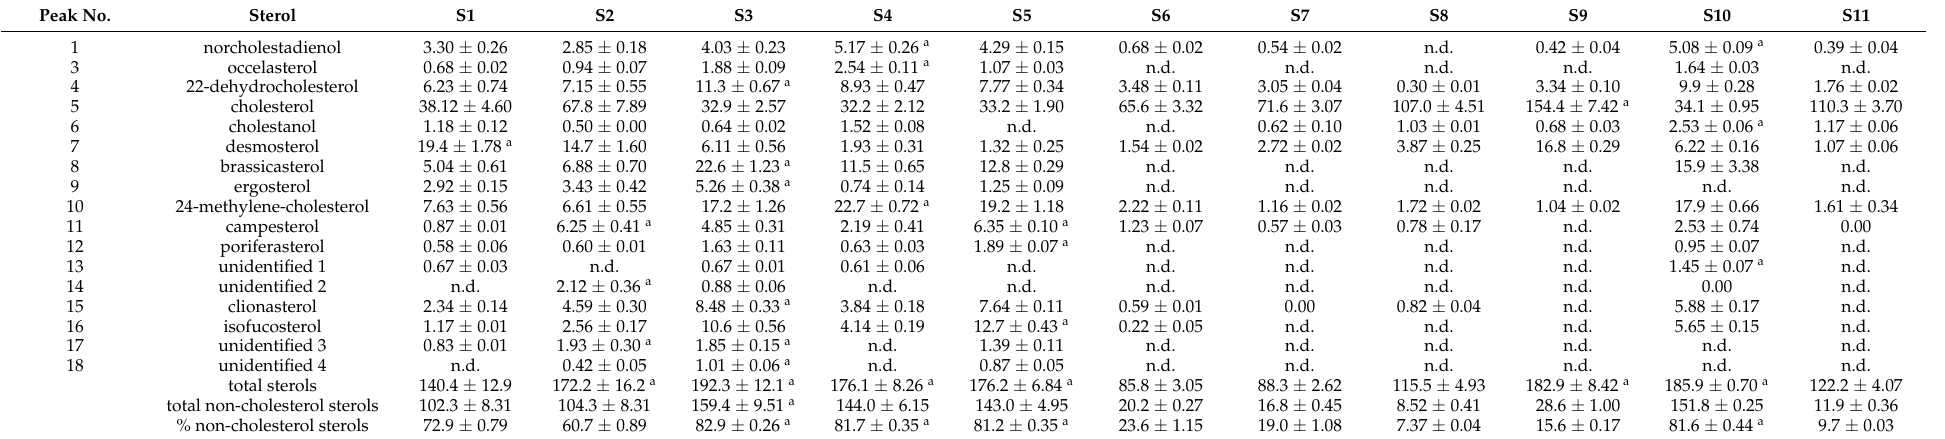
Table 3. Sterol composition of shellfish species.